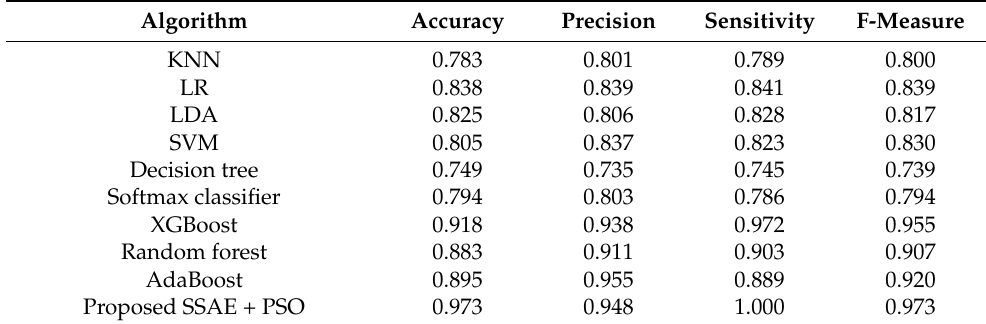
Table 3. Assessment of the performance of the algorithms using the Framingham dataset.